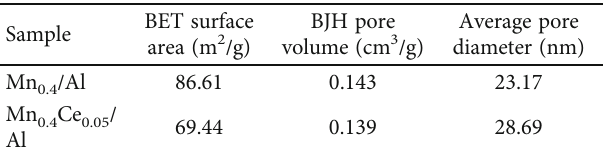
Table 2: Physical properties of